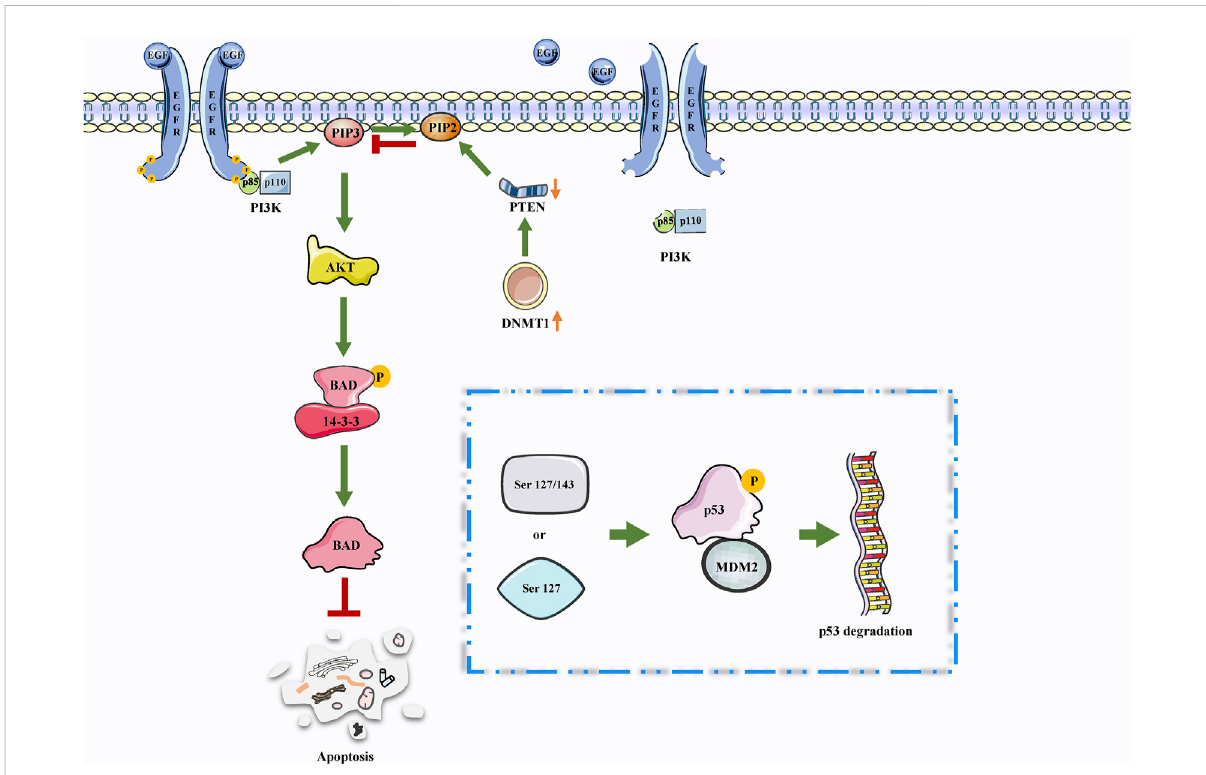
FIGURE 3 DNMTs may be involved in PTEN/PI3K/AKT. The PTEN/PI3K/AKT signaling pathway is involved in the regulation of apoptosis. Interestingly, the high expression of DNMTs leads to a decrease in PTEN expression. Therefore, DNMTs may further inhibit apoptosis through this